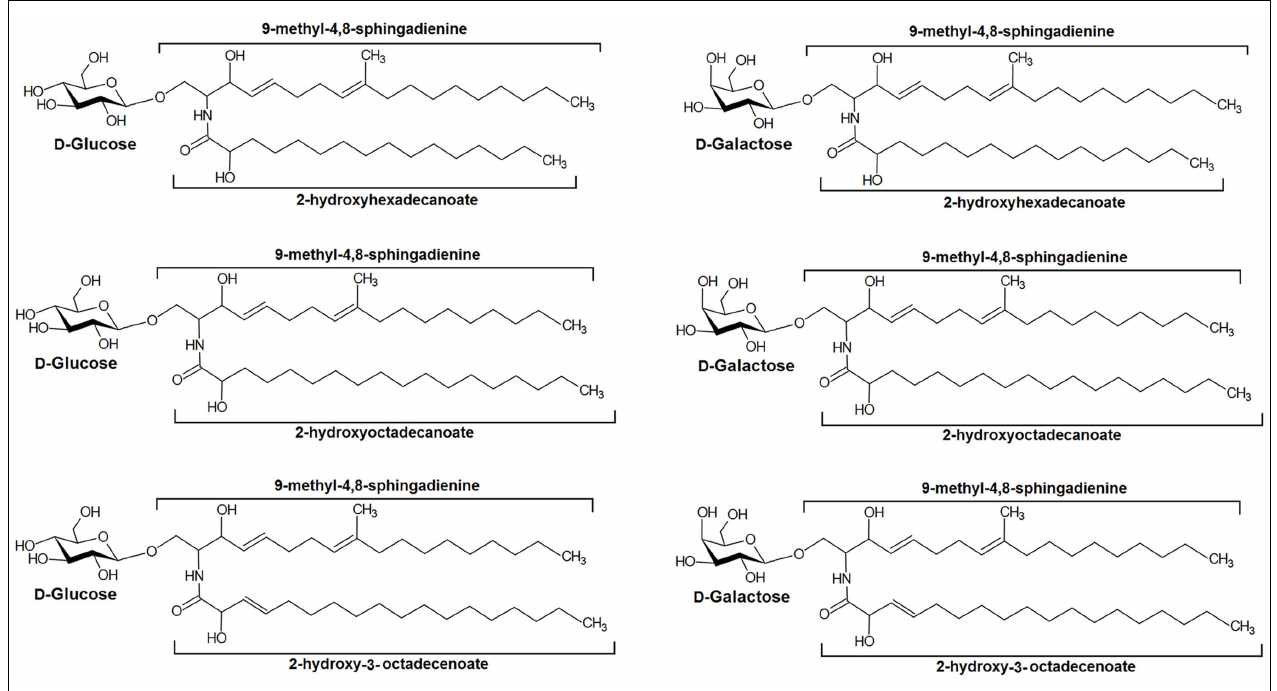
FIGURE 8 | Main structures of cerebrosides isolated from pathogenic fungi.